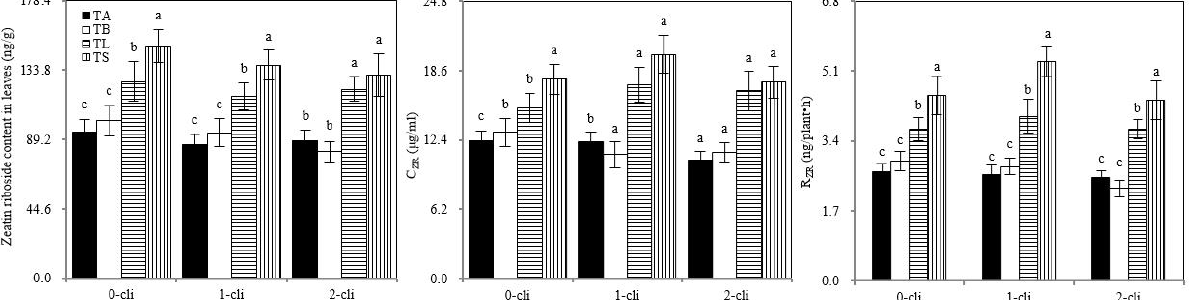
Figure 8. Zeatin riboside concentrations in the newly grown leaves, R ZR and C ZR in the xylem saps in different treatments in the experiment. TA, TB, TS, TL indicate treatments of regrowth with liquid medium without AOB added relatively long before defoliation, regrowth with liquid medium without AOB added shortly before defoliation, regrowth with S2_8_1 strain inoculated relatively long before defoliation, and regrowth with S2_8_1 strain inoculated shortly before defoliation, respectively. “0-cli”, “1-cli” and “2-cli” mean, respectively, days 0, 7 and 14 after defoliation. C ZR mean zeatin riboside concentrations in xylem sap. R ZR mean delivery rates of zeatin riboside from roots to leaves in the darkness. The values are the mean ± standard error (n = 3). The different letters in each row indicate significant differences ( p < 0.05).